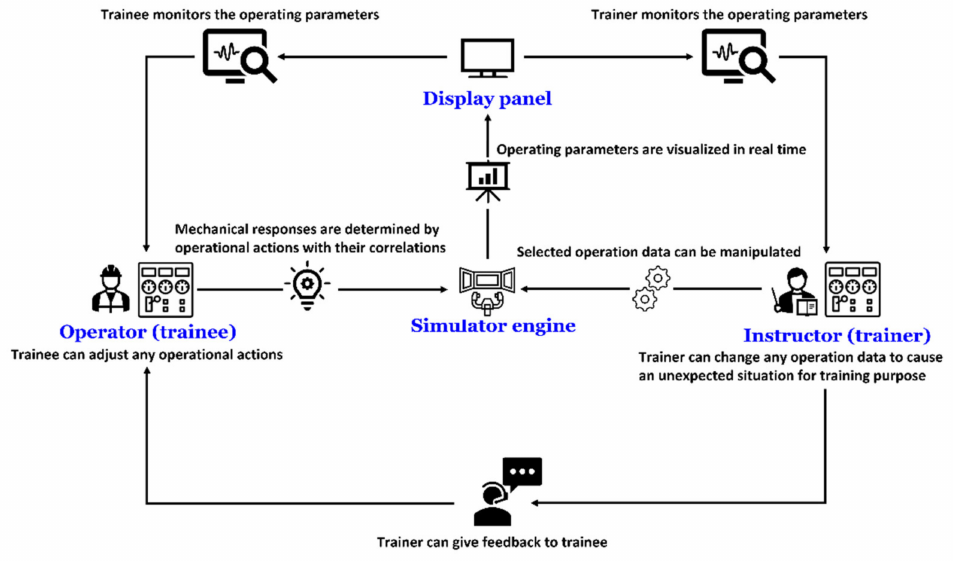
Figure 7. Architecture of the operating model for the TBM